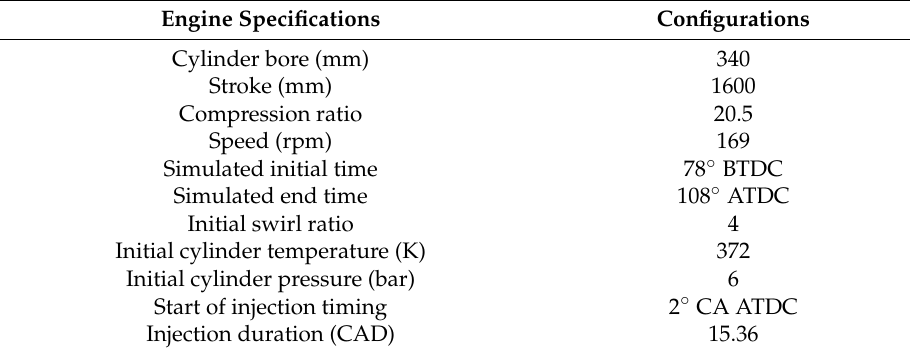
Table 2. Specifications and configurations of the marine engine.